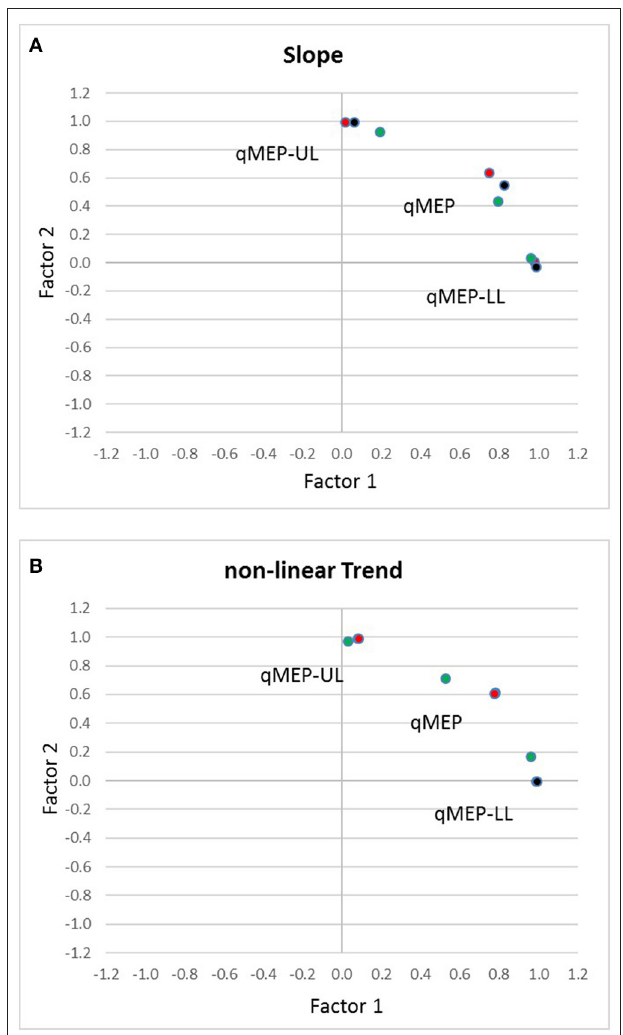
FIGURE 2 | Diagrams show the separation of quantitative MEP scores for upper (qMEP-UL) and lower limbs (qMEP-LL), as well as the combination of both (qMEP) along two independent dimensions obtained by factor analysis after Varimax rotation using (A) individual slopes (linear trends) (B) individual deviations from linearity (non-linear trends). The x - and y -coordinates of the variables are defined by their loadings on the first and second factors. Colors represent the different ways of calculating the scores from central motor conduction time (CMCT; red), shortest corticomuscular latency (CxM-sh; black), and mean CxM (CxM-mn;